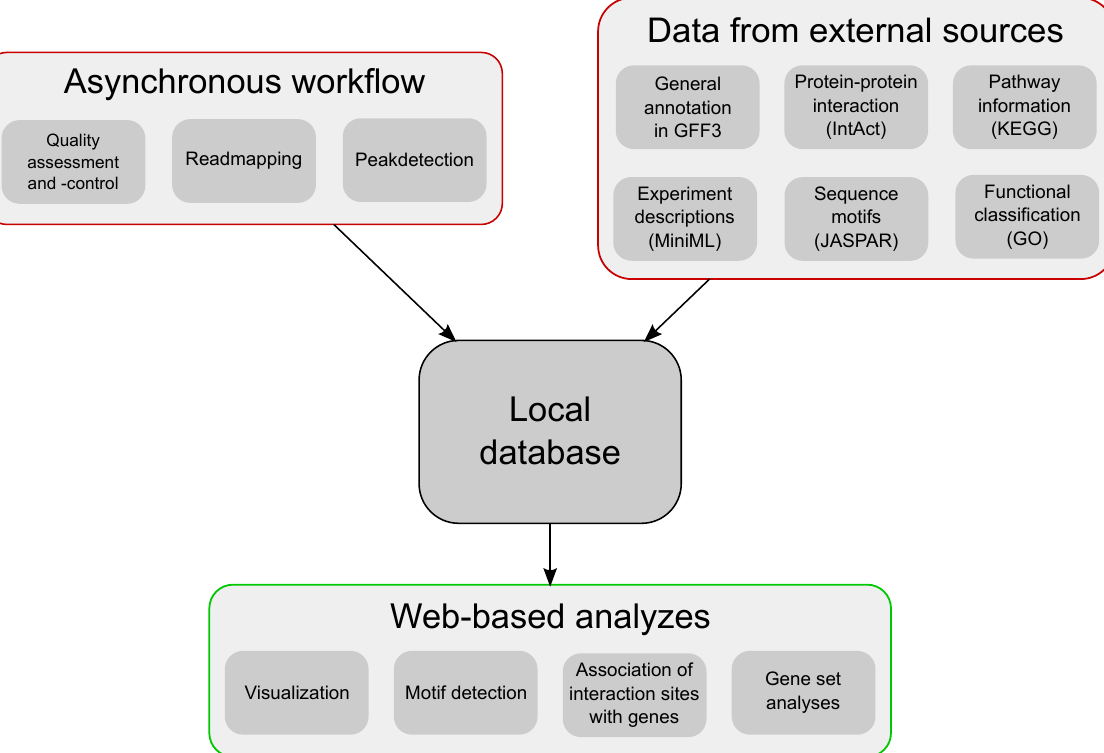
Figure 2: An overview of CASSys ’s system architecture. The asynchronous part (red) spans the computational analysis steps up to peakdetection and the parsing of data from external sources. Refined data resulting from these processes is persistently stored in a local database, and can be accessed in the web-based analyses of the interactive part